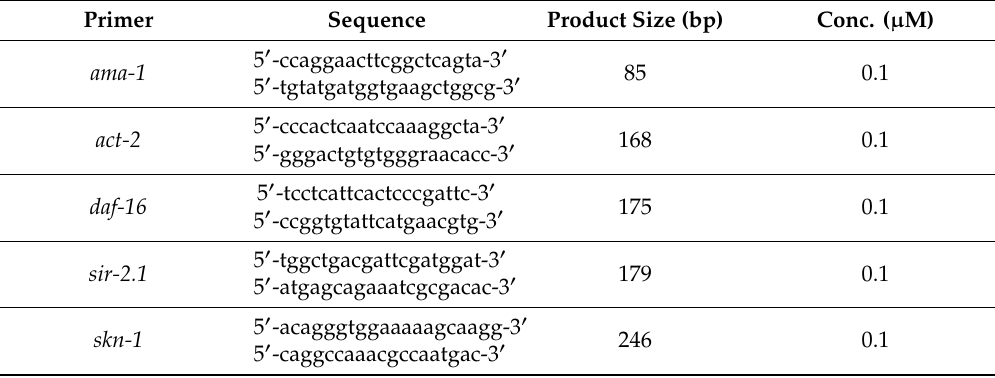
Table 1. Oligonucleotide primer sequences, product sizes, and primer concentrations for quantitative real-time PCR. Primer Sequence Product Size